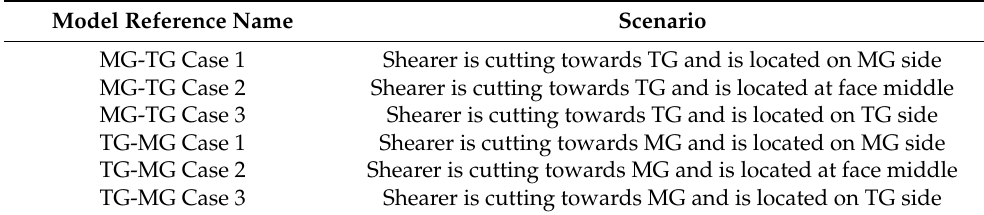
Table 3. Reference names of the longwall